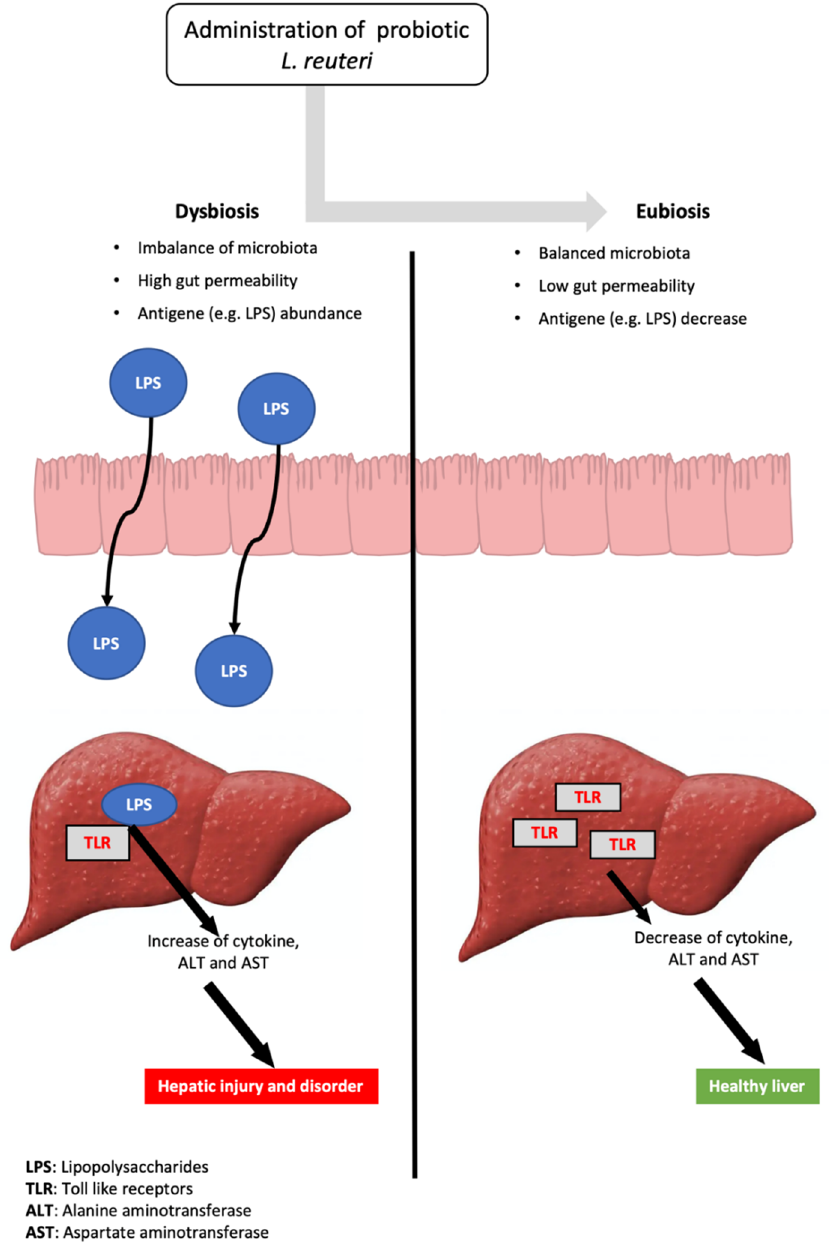
Figure 3. Administration of probiotic L. reuteri strains can alleviate hepatic injury and disorder. Probiotics, particularly Lactobacillus , can limit the growth of pathogens while also improving the host’s immunological and metabolic functioning. L. reuteri strains are widespread in the mammalian gut and have health-promoting qualities [13]. Jiang et al. [86] showed that treatment in advance with L. reuteri DSM 17938 reduced